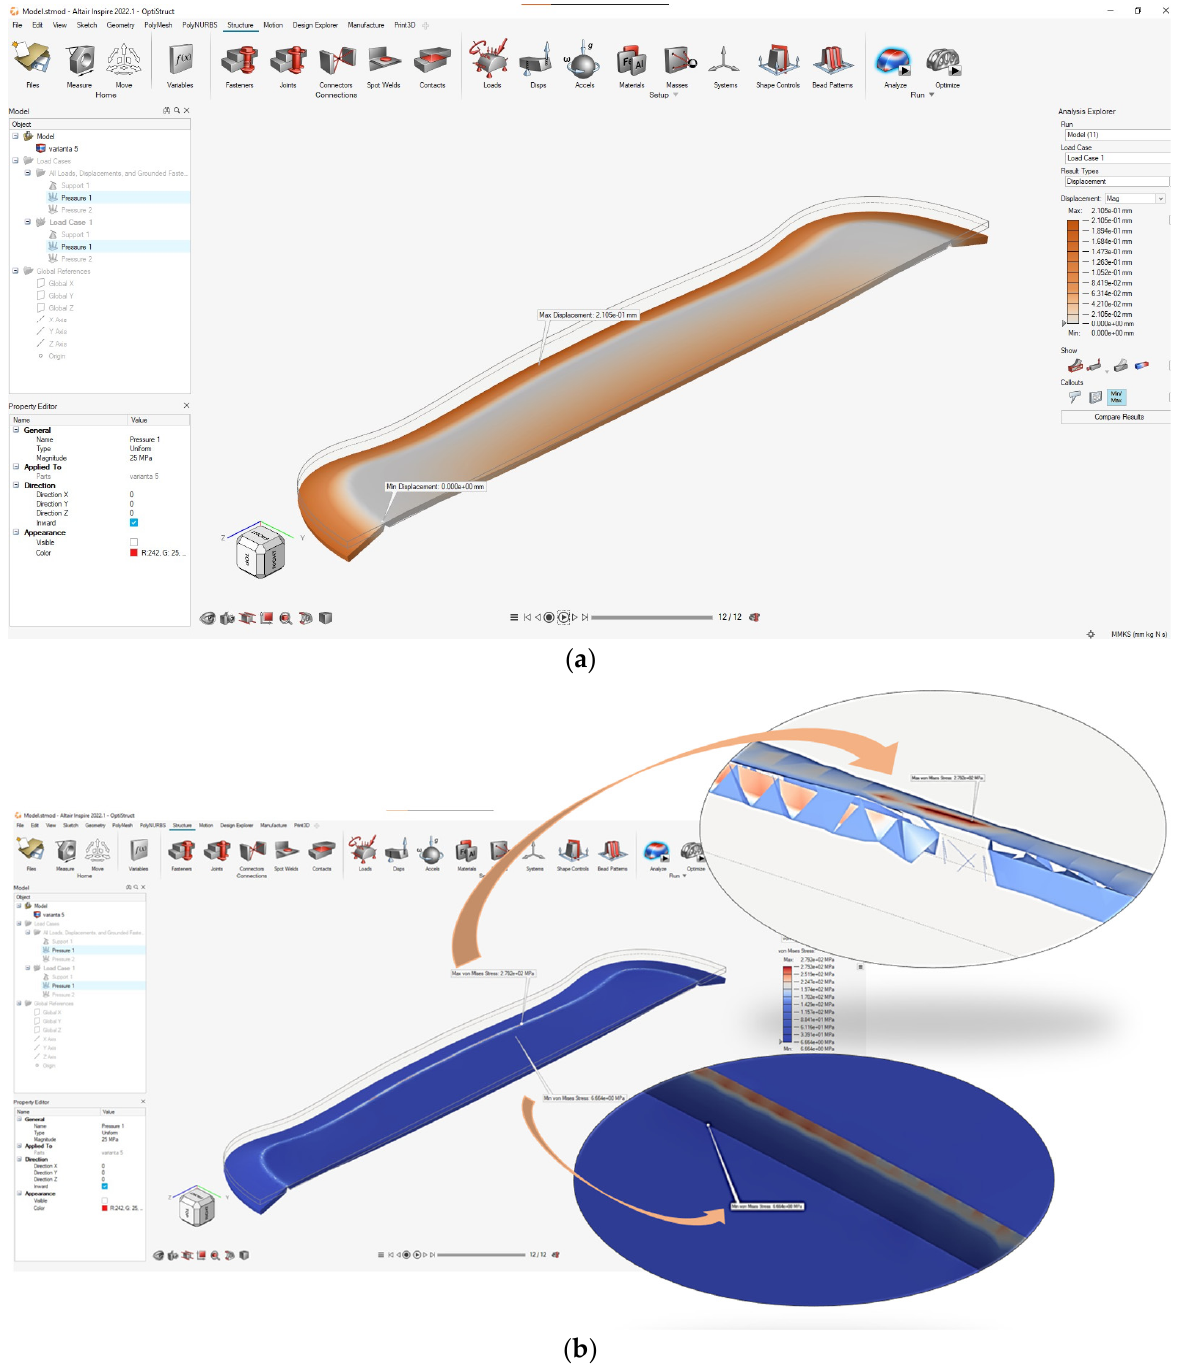
Figure 33. The model no. 4: ( a ) deformations; ( b ) von Mises equivalent stresses.